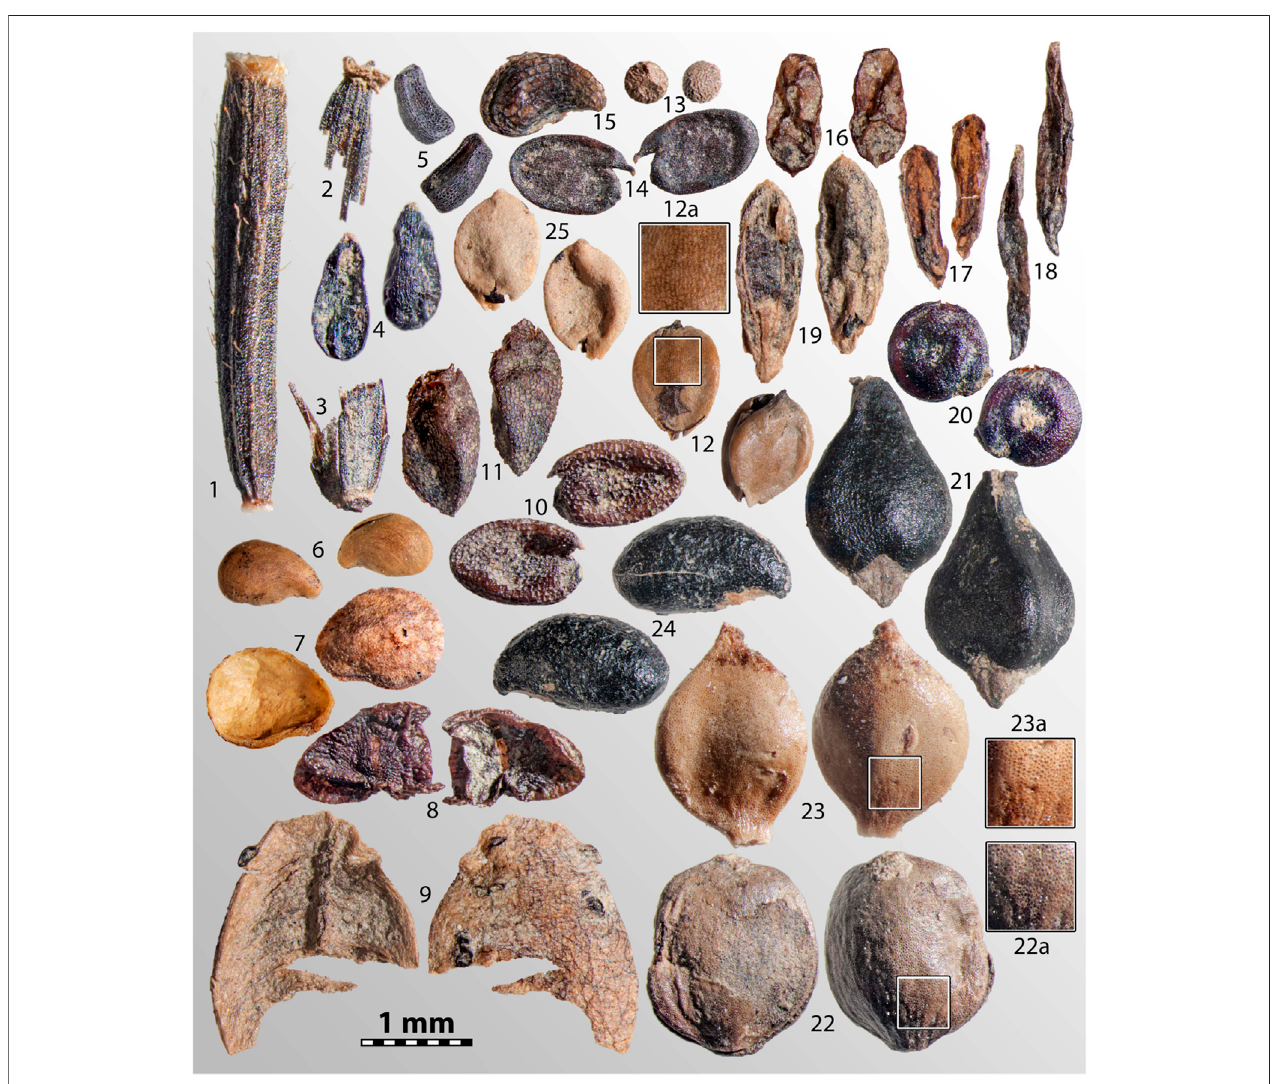
FIGURE4| Olyorianmacrofossilsofgrasslandandruderalplants.1 – Arnicafrigida ,moderncypselawithoutpappusasreference,1 – A.frigida ,fragmentofcypsela, upper part with preserved pappus ring, 3 – A. frigida , fragment of cypsela, basal part with abscission scar, 4 – Artemisia sp., cypsela from two sides, 5 – Saxifraga cernua , ancient seed, 6 – Potentilla arenosa , nutlets, 7 – Ranunculus pedati fi dus ssp. af fi nis , nutlet fragment (carpel) from two sides, 8 – Silene involucrata , seed from two sides, 9 – Phlox sibirica , valve fragment of seed pod, 10 – Smelowskia sp., seed from both sides, 11 – Androsace septentrionalis , seed from two sides, 12 – Rumex Subgen. acetosella ,nutletfromtwosides,12a – R. Subgen. acetosella ,detailofnutletsurface,13 – Selaginellarupestris ,megasporefromtwosides,14 – Draba sp.,seedfromboth sides,15 – Papaver Sect. Scapi fl ora ,seed, 16 – Poa sp.,caryopsisfrom twosides,notethecircularhilumnearthebaseat theleftpicture, 17 – Festuca sp.,caryopsisfrom two sides, note the linear hilum at the centre of the fruit, 18 – Koeleria sp., caryopsis from two sides, 19 – Puccinellia sp., caryopsis from two sides, 20 – Chenopodium cf. prostratum , seed from both sides, 21 – Polygonum aviculare , nutlet from two sides, 22 – Carex duriuscula , ancient nutlet from both sides, 22a – detail of surface, 23 – C. duriuscula , modern nutlet for comparison, 23a – detail of surface, 24 – Sibbaldianthe bifurca , nutlet from two sides, 25 – Urtica dioica , ancient seed from two sides.